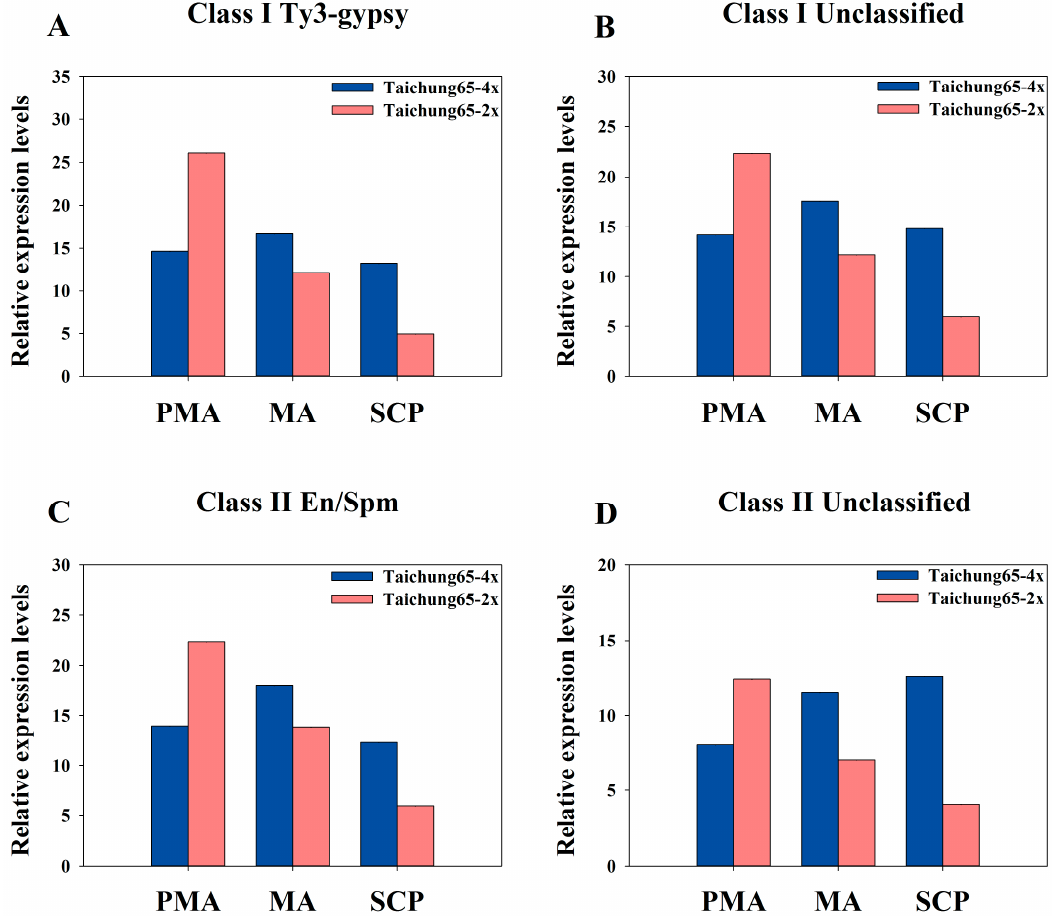
Figure 6. Abundance of siRNAs transposable elements associated with Taichung65-4x and Taichung65-2x during pollen development stages: ( A ) Ty3-gypsy type of class I; ( B ) unclassified type of class I; ( C ) En/Spm type of class II; and ( D ) unclassified type of class II. PMA, MA and SCP represent pre-meiotic interphase, meiosis and single microspore stage, respectively. “4x” and “2x” represent the autotetraploid and diploid rice, respectively.